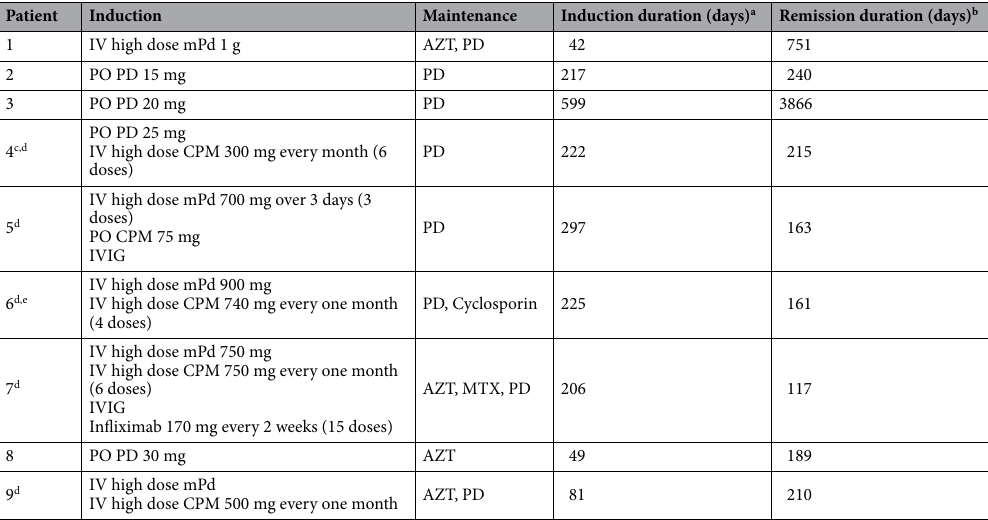
Table 2. Initial treatment. Initial treatment of nine patients. IV: intravenous; mPd: 6-methylprednisolone; AZT: azathioprine; PD: prednisolone; PO: oral administration; CPM: cyclophosphamide; IVIG: intravenous immunoglobulin G; MTX: methotrexate. a From the initial treatment to the start of steroid dose reduction. b From the start of maintenance therapy to the last follow-up or to the first relapse. c Patient 4 was treated with IVIG and several mPD pulse therapies before being diagnosed with PAN. d Treated with nifedipine ointment and alprostadil for Raynaud’s phenomenon. e Oral cyclosporin A was used for maintenance and was stopped because of hypertensive encephalopathy.